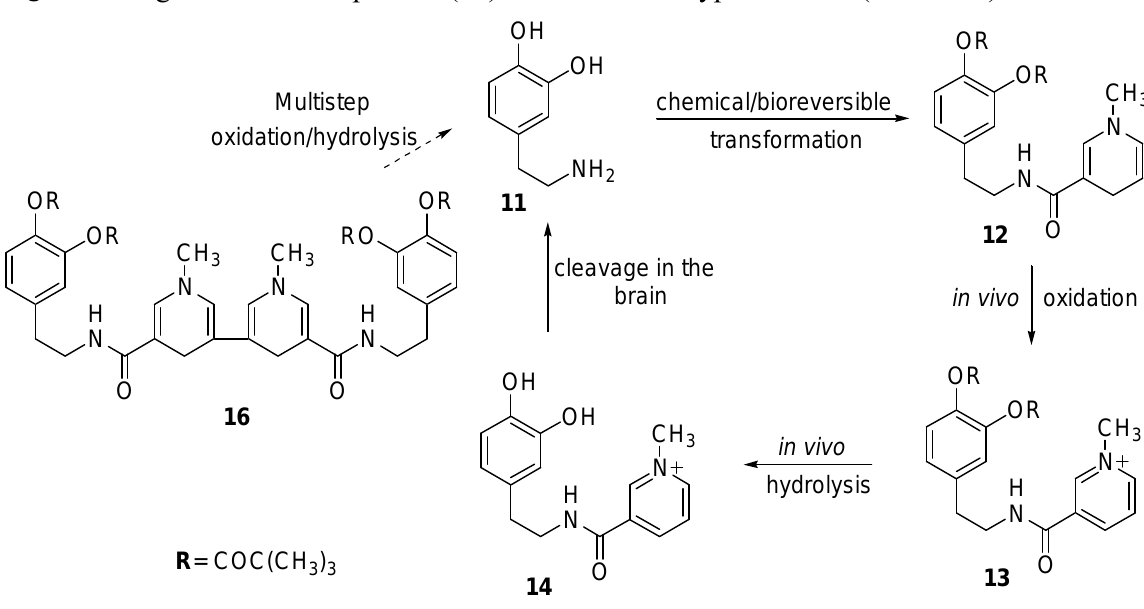
Figure 4. Regeneration of dopamine ( 11 ) from its amide-type of CDSs ( 12 and 16 ) in the